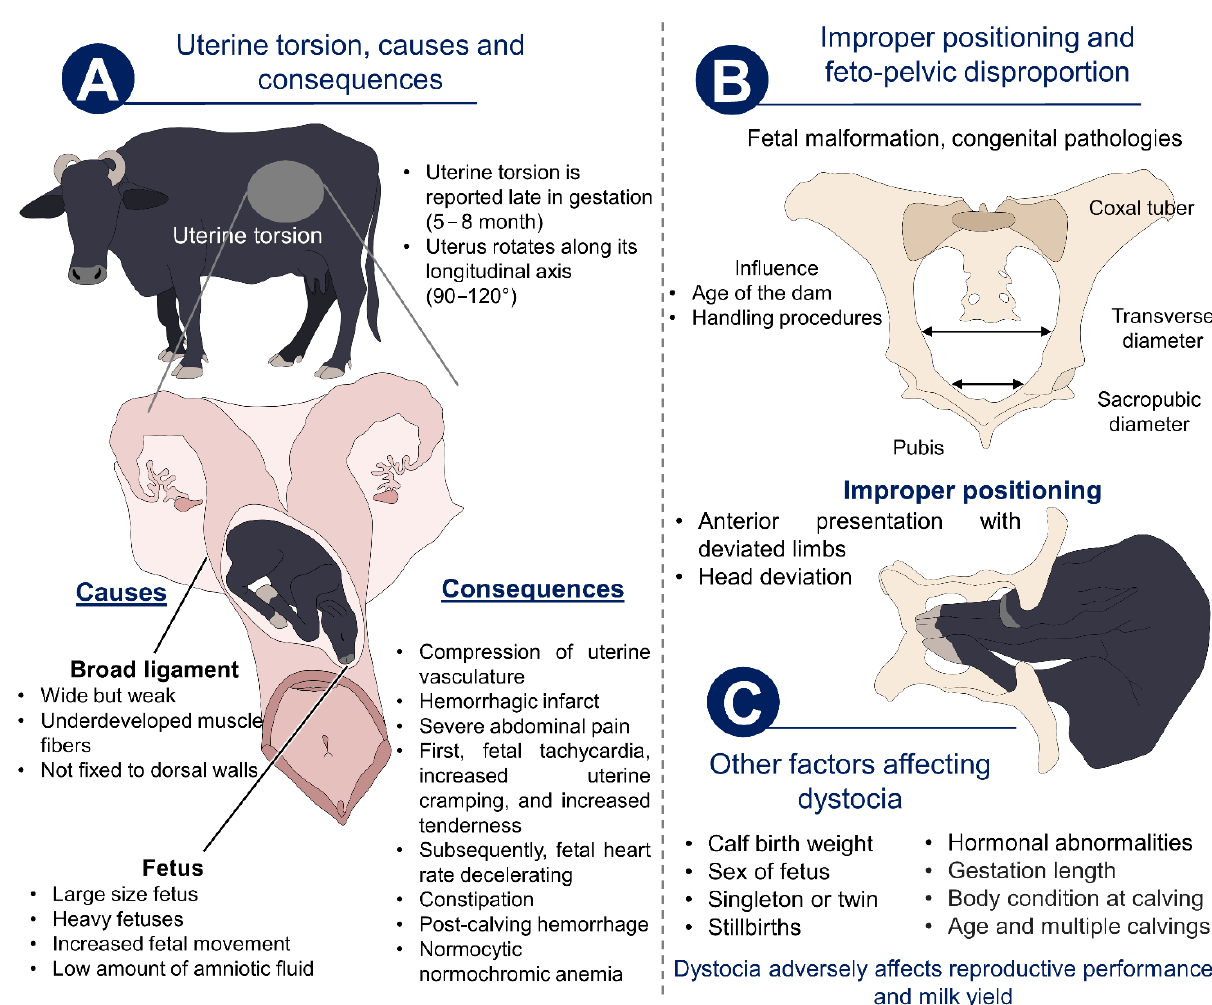
Figure 2. Maternal and fetal causes of dystocia in buffaloes. ( A ) Uterine torsion as the main complication during calving due to anatomical aspects such as a weak and underdeveloped broad ligament, as well as a large fetus, low amounts of amniotic fluid, and fetal movements. ( B ) Fetal–pelvis disproportions and improper positioning of the fetus are causes of dystocia that need to be treated or recognized early to avoid health consequences. ( C ) Other